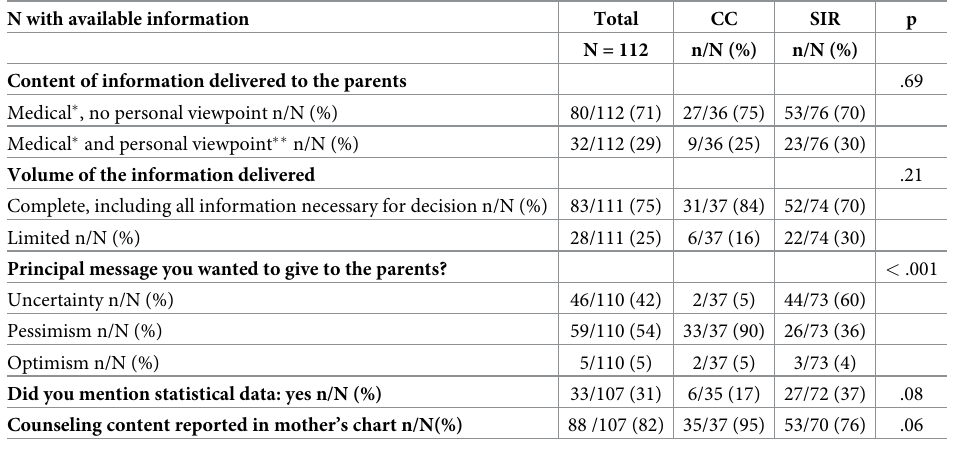
Table 5. Characteristics of information provided at predelivery counseling, reported by health-care professionals. N with available information